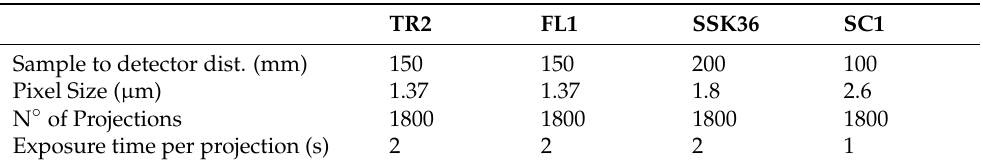
Table 1. Experimental parameters used for the tomographic scan. The filter used for all samples was 1.5 mm of Si plus 1 mm of Al.